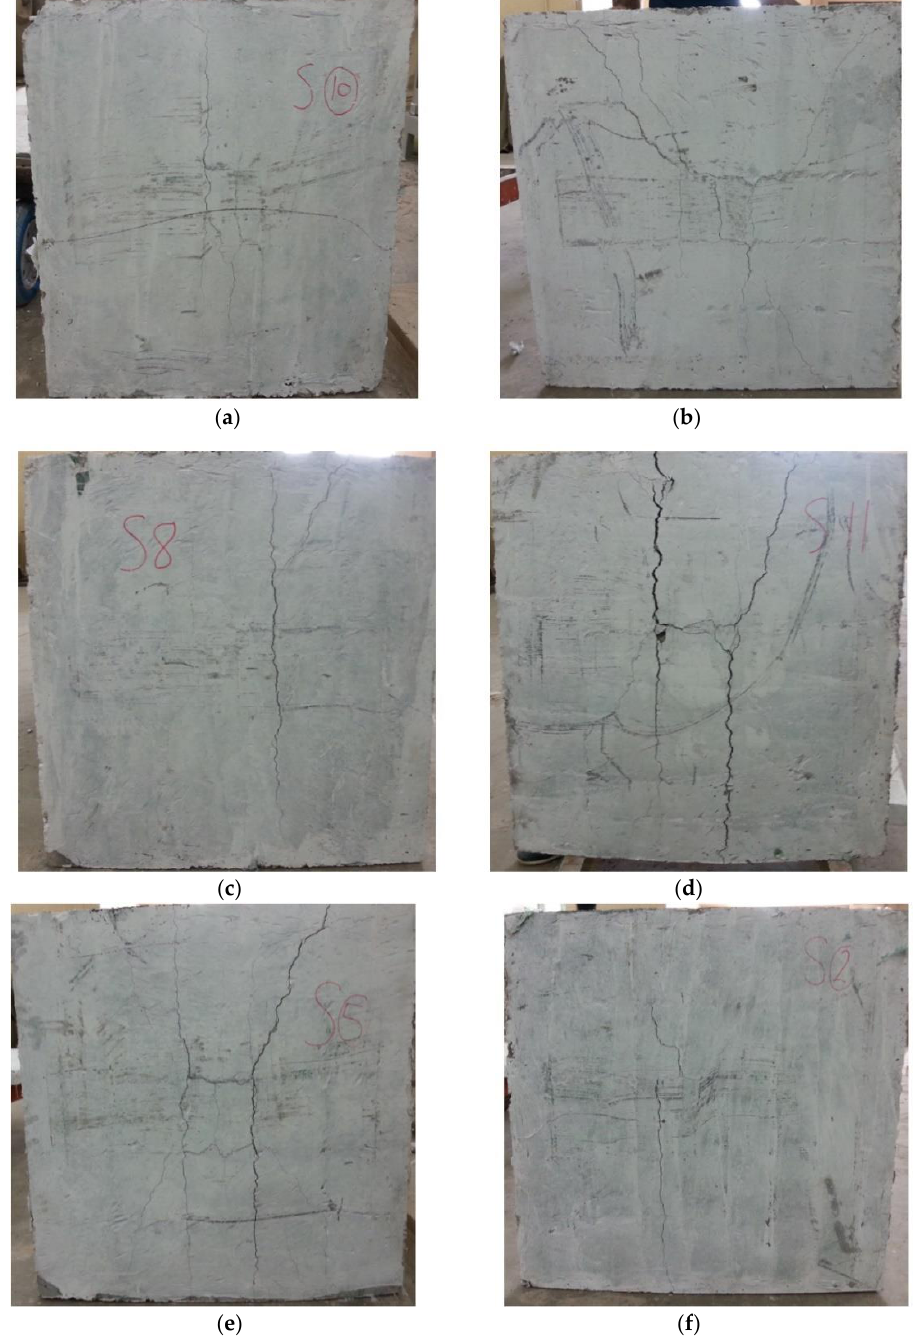
Figure 10. Failure mode of ( a ) Con, ( b ) PVC-15, ( c ) PVC-30, ( d ) PVC-60, ( e ) PVC-60-PVA, and ( f ) PVC-60-Fiber